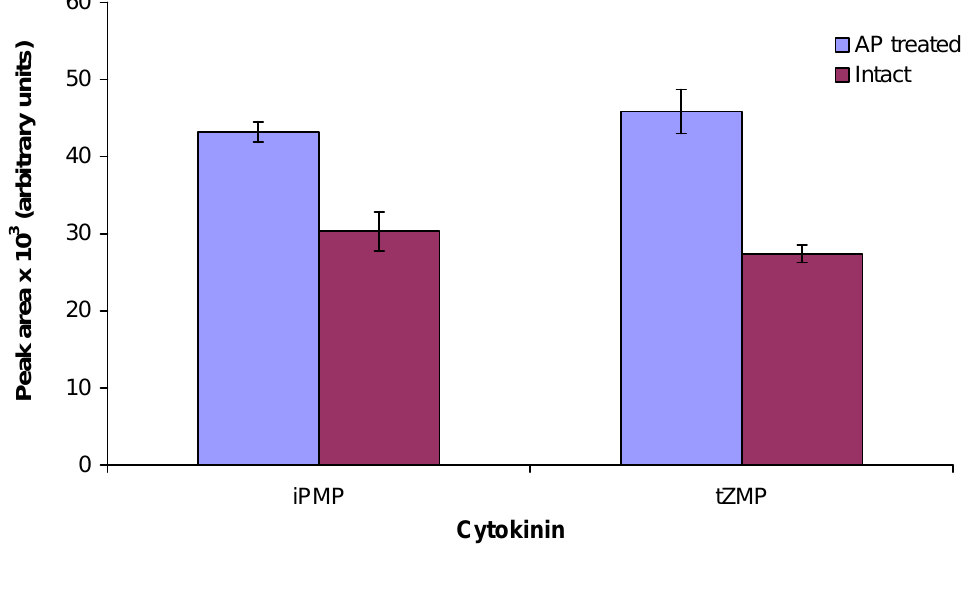
Figure 3. Cytokinin nucleotides analyzed by UPLC-MS/MS as intact monophosphates and after AP treatment. 0.5 pmol of each cytokinin was injected onto the chromatographic column and detected by MS using multiple reaction monitoring mode. The intensities of the mass spectrometric signals corresponding to the first isotopomer (I0) are